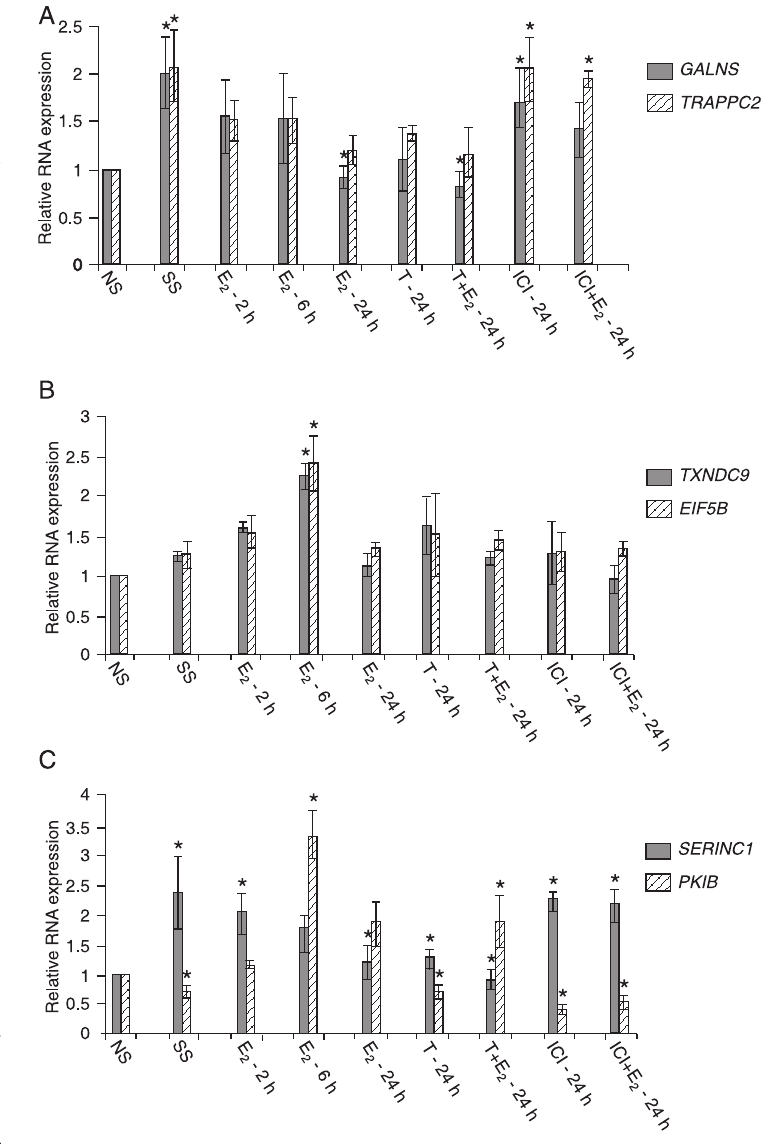
Figure 4. Effects of 17β-estradiol (E 2 ) and the anti-estrogens tamoxifen (T) and ICI 182,780 (ICI), on the transcriptional regulation of the bidirectional gene pairs GALNS/TRAPPC2L (A), TXNDC9/EIF5B (B), and SERINC1/PKIB (C) in MCF- 7 breast cancer cells. Synchronized MCF-7 cells were cultured in: NS, medium supplemented with 5% fetal calf serum (FCS); SS, medium supplemented with 5% charcoal-stripped FCS; E 2 - 2 h, exposed to E 2 (10 nM) for 2 h; E 2 - 6 h, exposed to 10 nM E 2 for 6 h; E 2 - 24 h, exposed to 10 nM E 2 for 24 h; T - 24 h, exposed to 1 μM tamoxifen for 24 h; T+E 2 - 24 h, exposed to 1 μM tamoxifen plus 100 nM E 2 for 24 h; ICI - 24 h, exposed to ICI 182,780 for 24 h, or ICI+E 2 - 24 h, exposed to ICI 182,780 plus E 2 (100 nM) for 24 h. Data are reported as means ± SD of three experiments. *P < 0.05 compared to NS and/or SS (one-way ANOVA followed by the Bonferroni